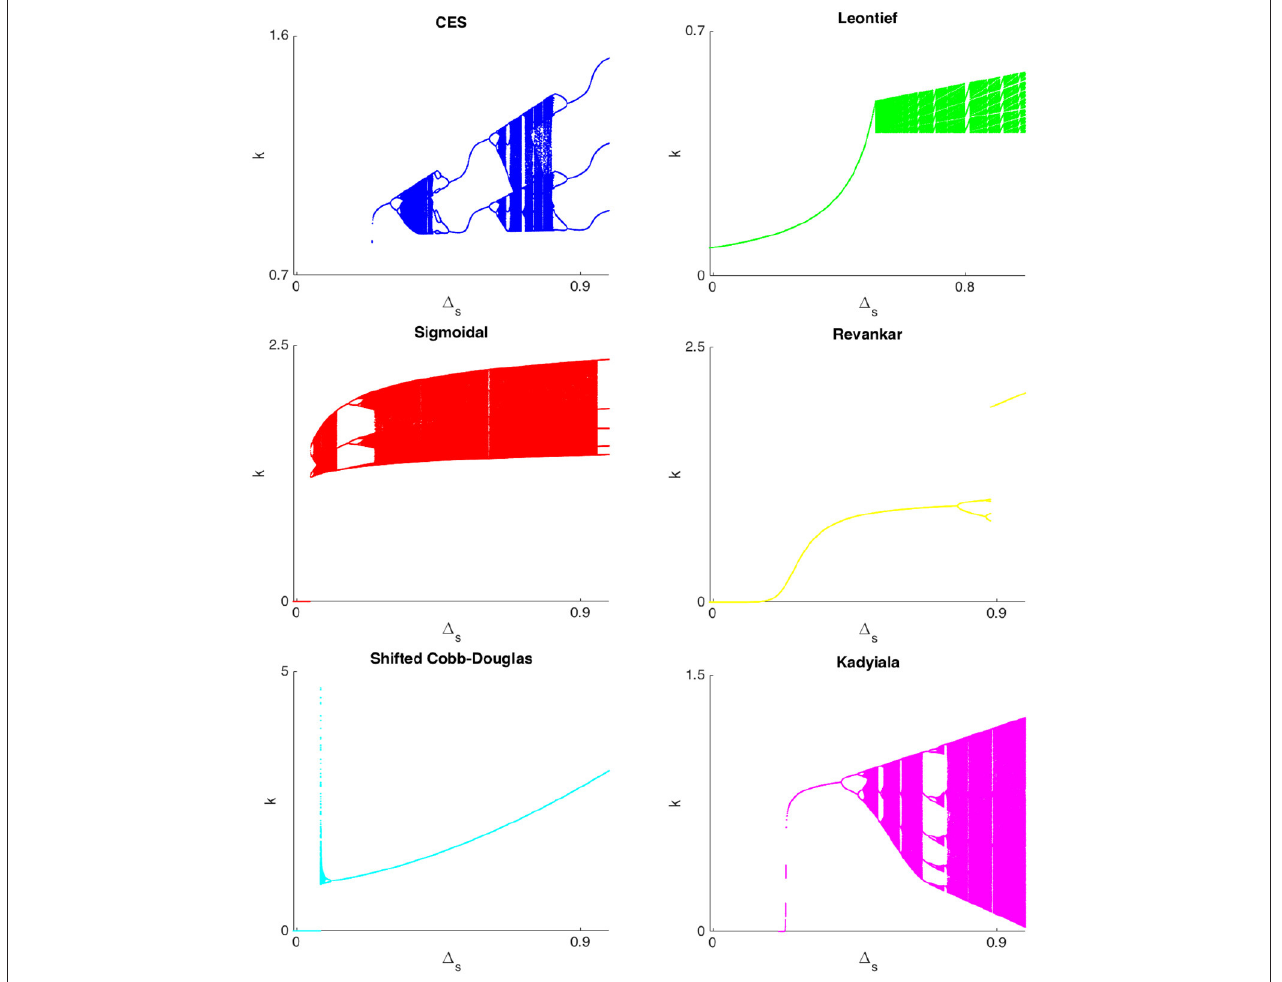
FIGURE 4 | Bifurcation diagram w.r.t. 1 s for BK model considering CES (blue), Leontief (green), sigmoidal (red), Revankar (yellow), SCD (cyan), and Kadyiala (magenta) technologies.